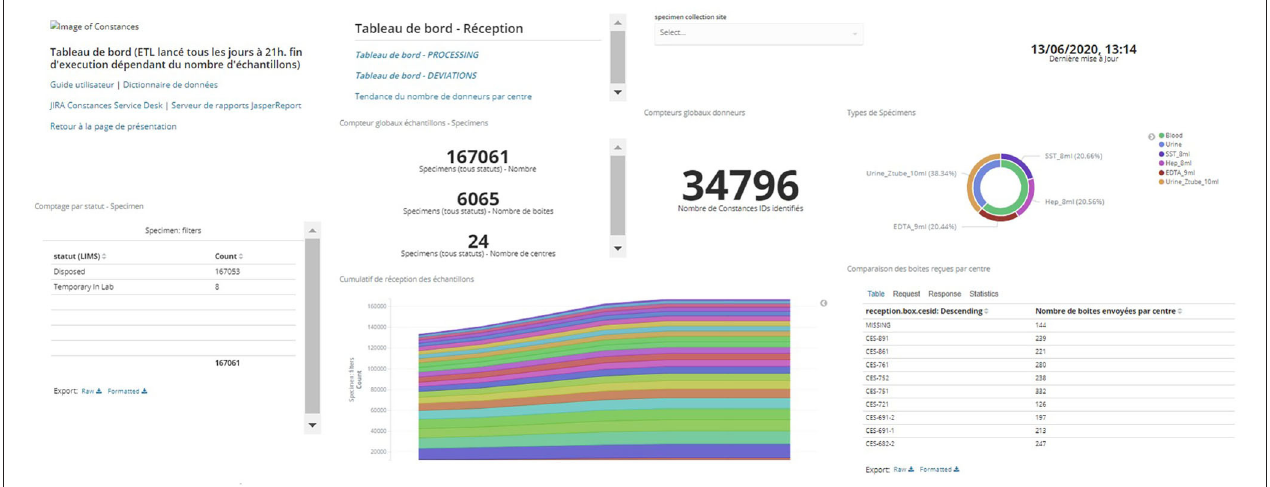
FIGURE 4 | Example of data warehouse dashboard: Reception